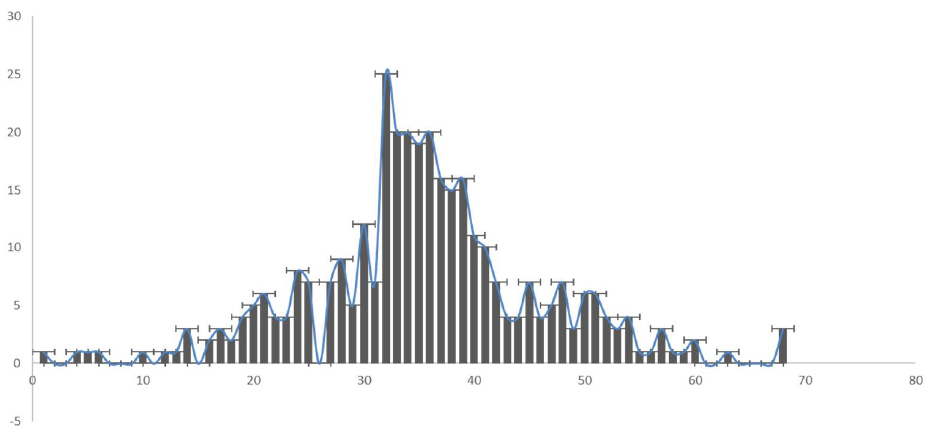
Figure 2. Monthly return distribution between 15 September 2014 to 15 September 2021.